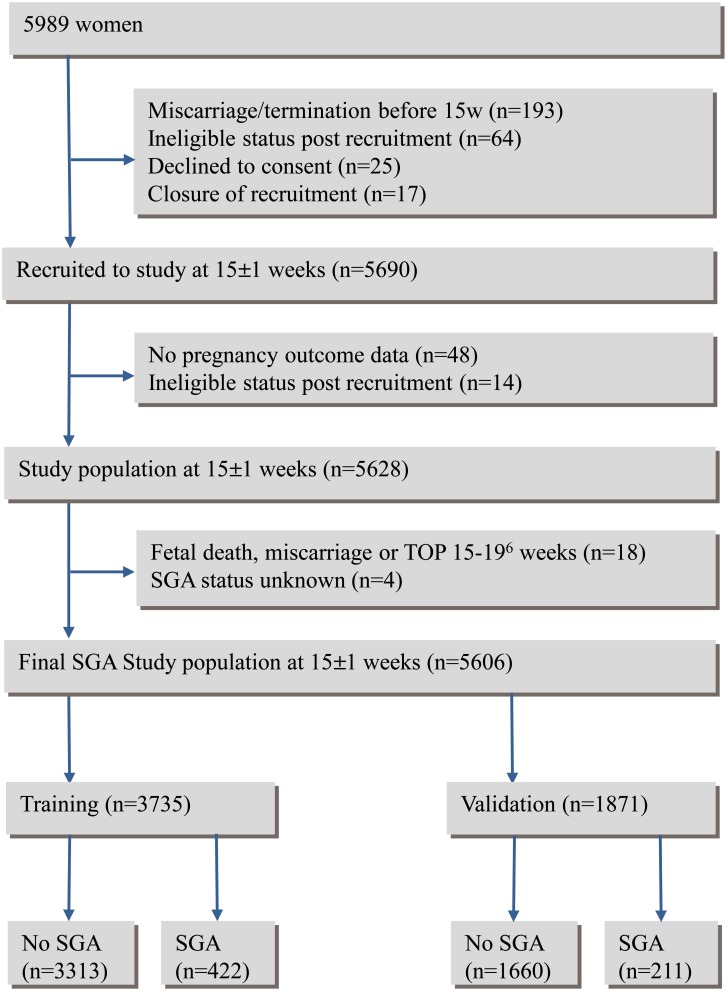
Flow chart of study population.